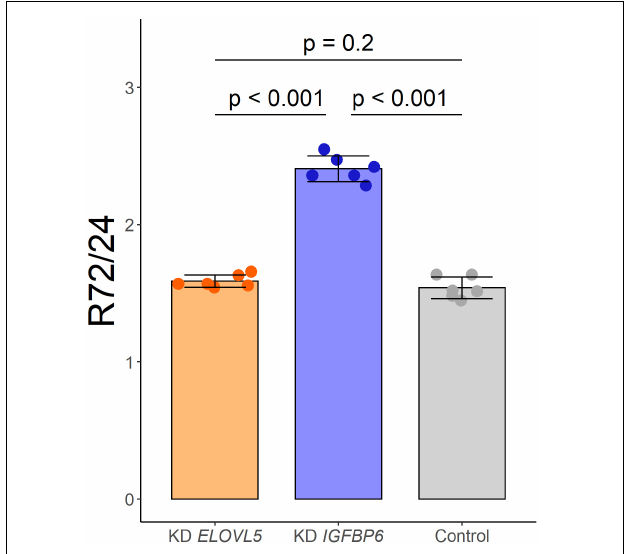
p = 0.006). In addition, the proportion of viable cells in the population increased significantly (by about 11%, p =